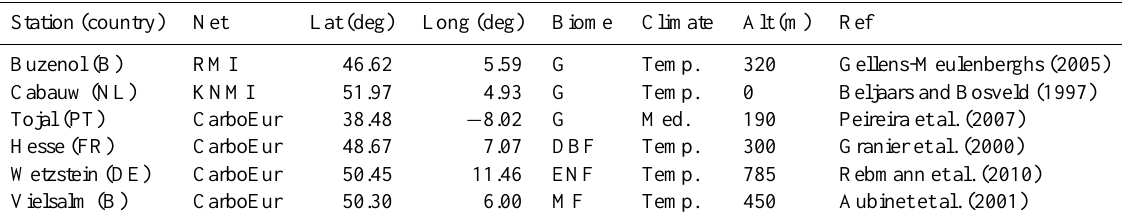
Table 2. Used flux stations for validation. Network (Net): Royal Meteorological Institute of Belgium (RMI), Koninklijk Nederland Mete- orologische Instituut (KNMI), CarboEurope (CarboEur). North Latitude (Lat), East Longitude (Long). Biome types: mixed forest (MF), evergreen needle leaf forest (ENF), deciduous broadleaf forest (DBF), grassland (G). Elevation (Alt) of the site above sea level. Climate: temperate (Temp), Mediterranean (Med). Reference